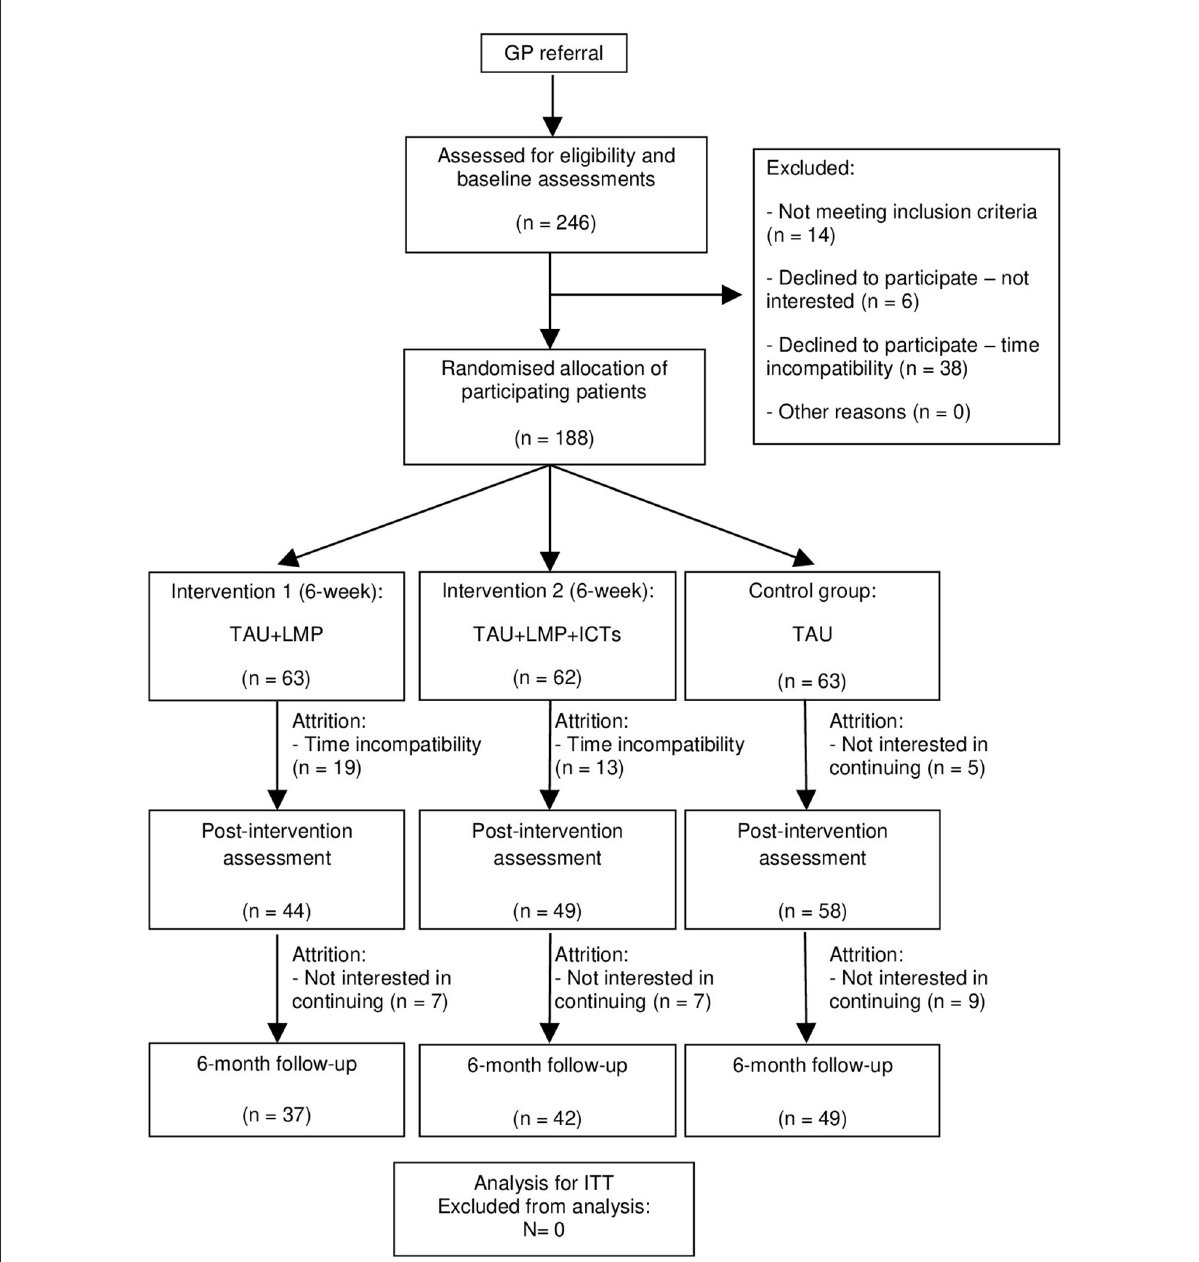
FIGURE1 Flowchart of the study: randomization, sampling and monitoring of patients . GP, General Practitioner; TAU, Treatment as Usual; LMP, Lifestyle Modification Programme; ICTs, Information and Communication Technologies; ITT, Intention-to-treat.